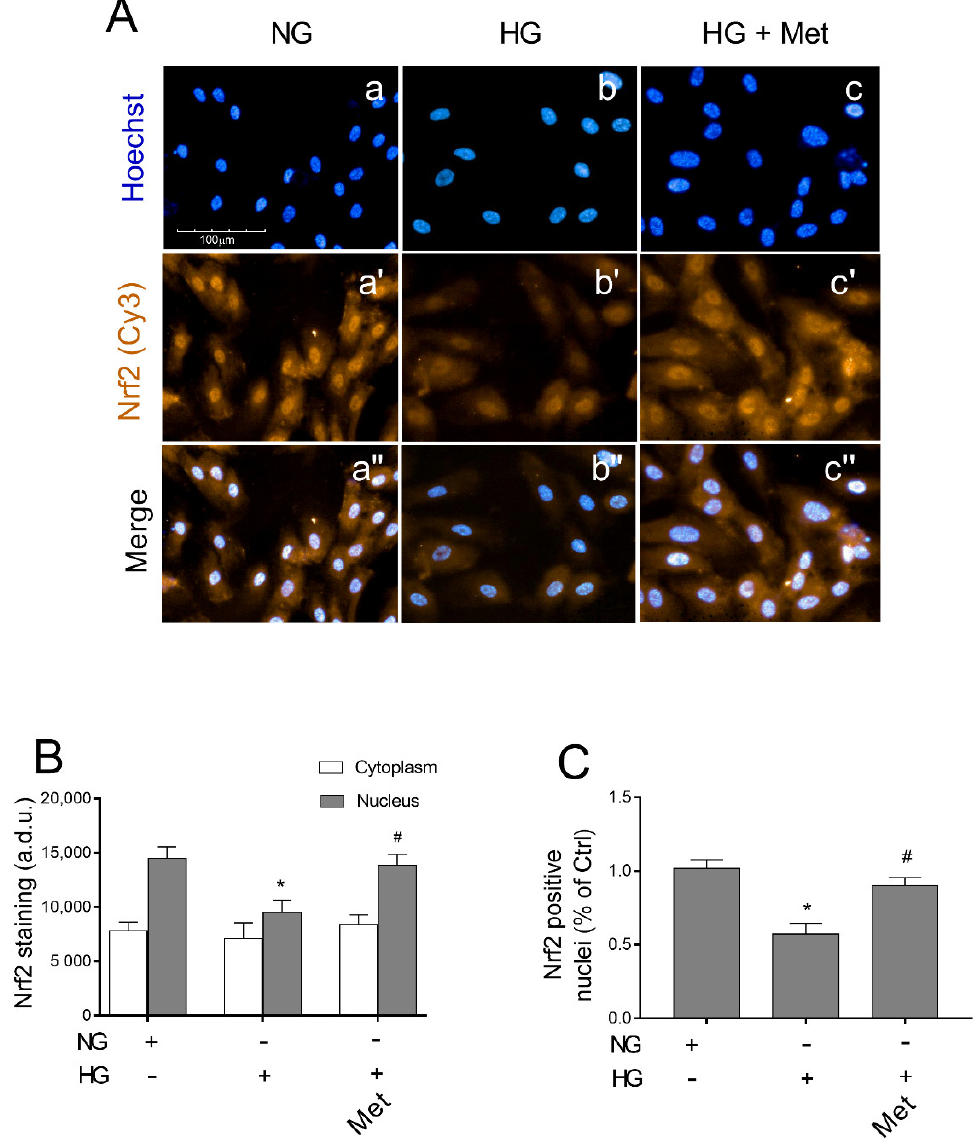
Figure 8. The effects of metoprolol on Nrf2 nuclear translocation in HREC that was stimulated with high glucose levels. ( A ) The representative of immunocytochemically stained images for Nrf2 in HREC that was cultured in normal glucose levels (NG, 5 mM) or in HG, (25 mM) alone or supple- mented with metoprolol (Met, 10 μM) for 48 h (in red: a′–d c’ respectively). Moreover, the relative Hoechst-stained nuclei (a–c, respectively) and merged channels (a′′–c′′, respectively) are shown. All images were acquired with the Operetta High-Content Imaging System using a 20× magnification; scale bar = 100 μm. ( B ) High-content screening analysis was used to quantify the green fluorescence (Cy3) relative to the Nrf2 staining in the cytoplasm and nuclei. ( C ) Quantification of Nrf2 positive nuclei. The data are expressed as the mean ± SD from at least six fields/well randomly selected and each reporting more than 15 cells/field. All of the data represent the mean ± SD that were obtained from at least three independent experiments with four parallel samples for group in each experi- ment. * p < 0.05 vs. NG; # p < 0.05 vs. HG. The non-parametric Mann-Whitney test was used for pairwise comparisons.